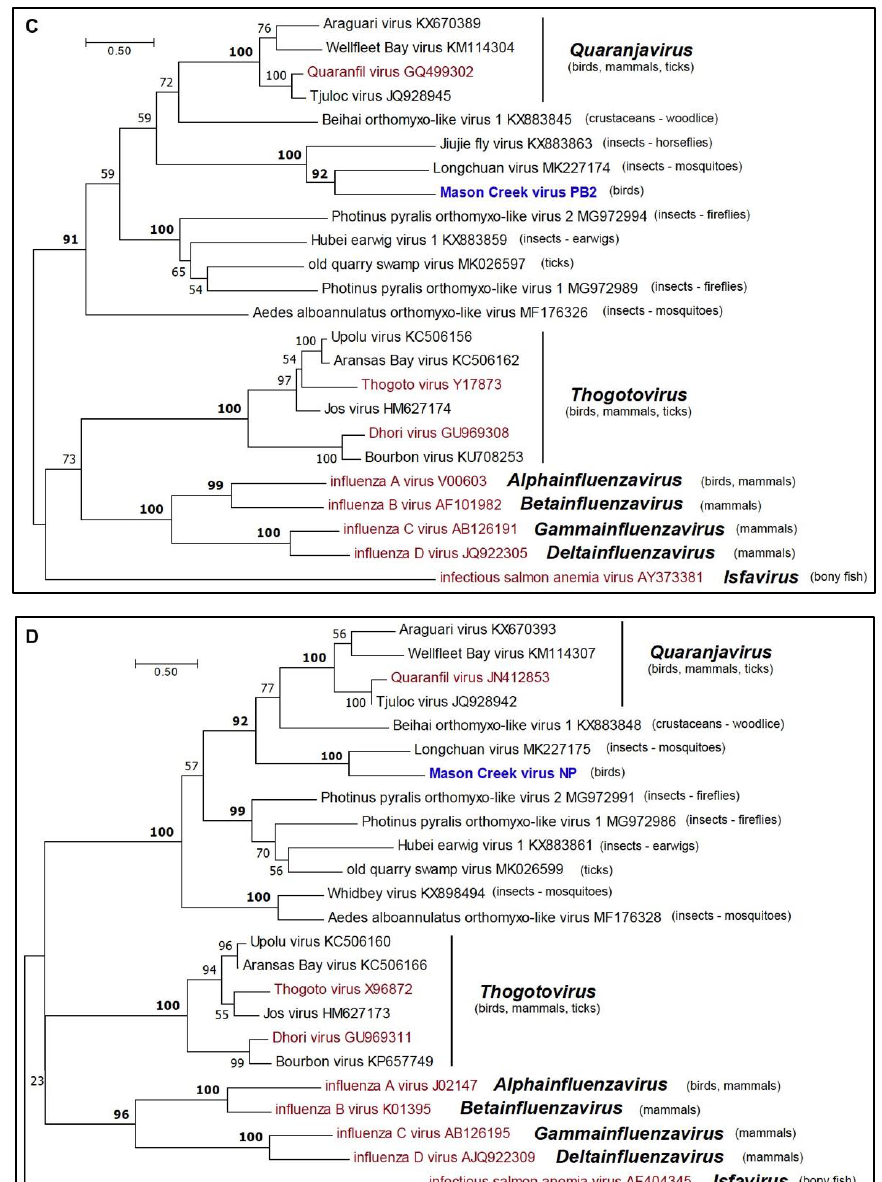
Figure 4. Maximum likelihood phylogenetic trees for amino acid sequences of representative members of the family Orthomyxoviridae . ( a ) PA proteins; ( b ) PB1 proteins; ( c ) PB2 proteins; and ( d ) NP proteins. Branch lengths are proportional to the number of nucleotide substitutions per site. Values for bootstrap support proportion (BSP) were determined from 100 bootstrap iterations. BSP values showing strong support for each of the key nodes are shown in bold. In each tree, viruses formally assigned to species are shown in magenta and the position of MCV is shown in blue. The Genbank accession numbers of all sequences are as shown.